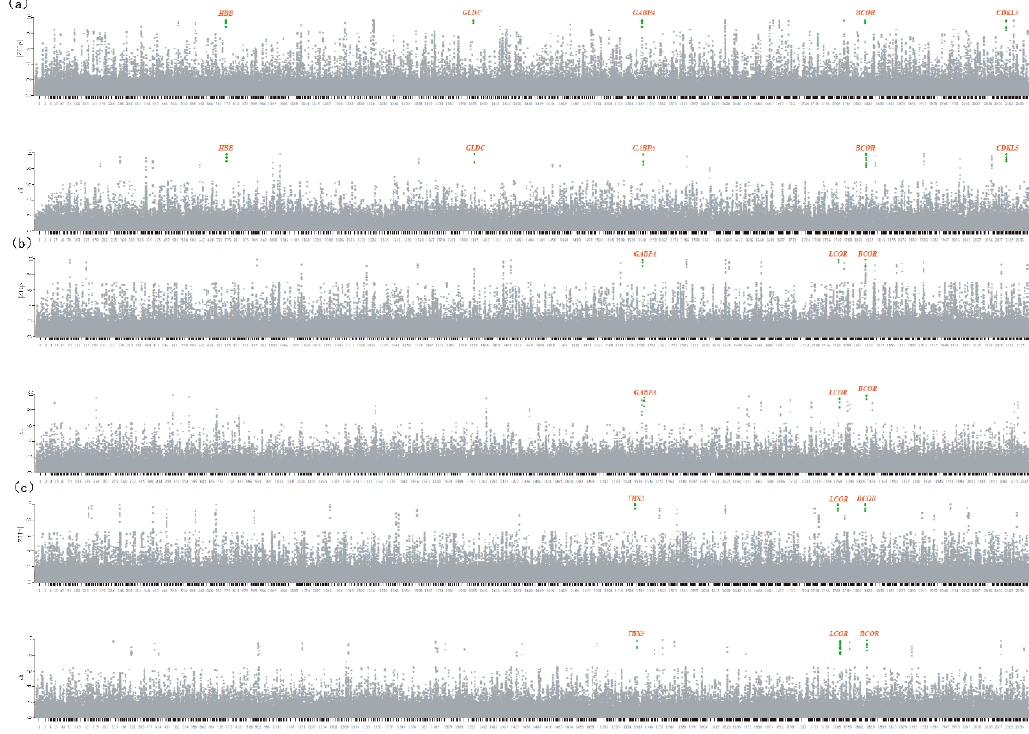
Figure 3. Overview of selective sweeps in the Qinghai, Guola, and Kulun donkeys plotted by ZHp and di values. ( a ) Qinghai breed. ( b ) Guola breed. ( c ) Kulun breed. Table 3. Overlapping genes identified by both ZHp and di for different donkey breeds.